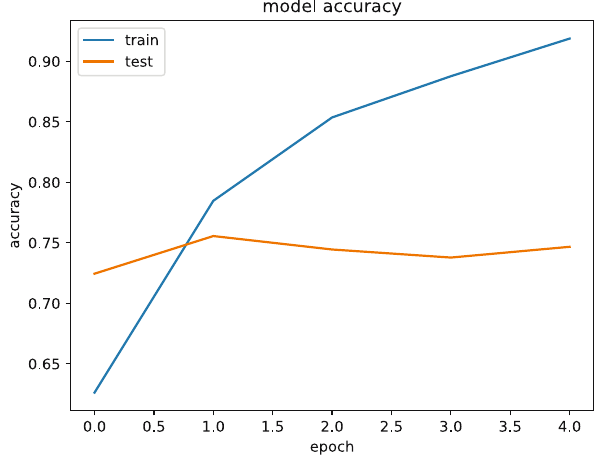
Figure 13: Train_test accuracy of attention model.